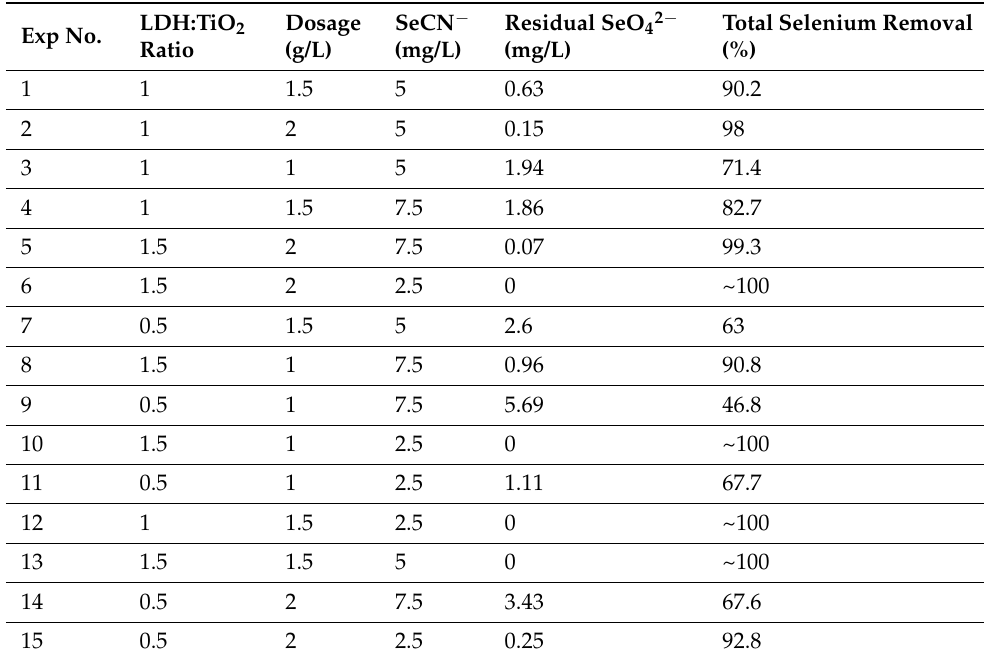
Table 2. The RSM based design of experiments for the photocatalysis work. Exp